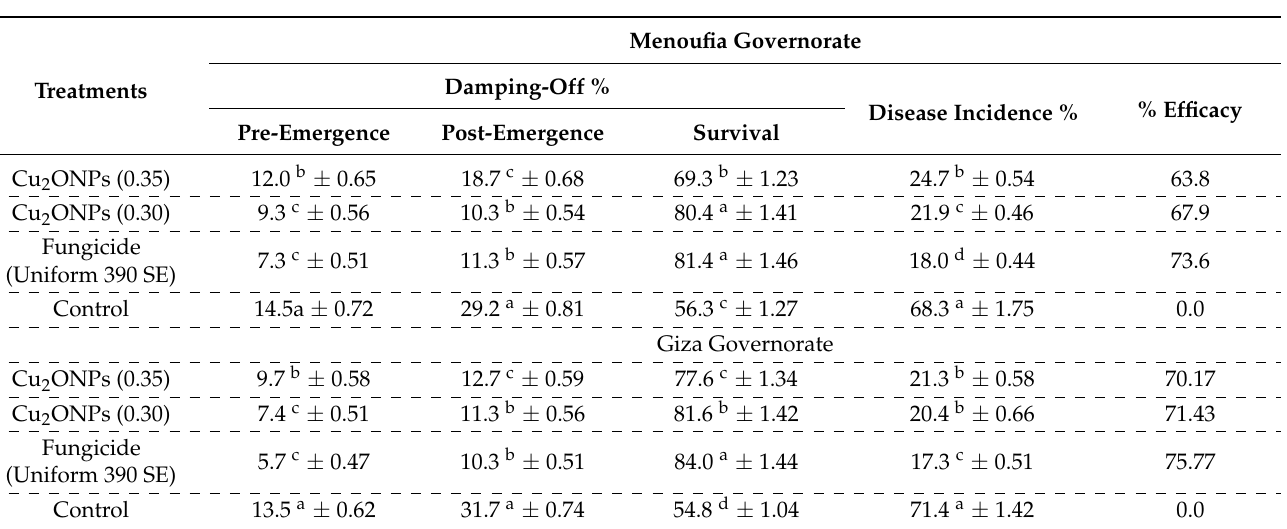
Table 5. Effect of Cu 2 ONPs compared to the fungicide on the percentages of damping-off and root rot disease incidence of F. solani in cucumber plants under field conditions in Menoufia and Giza Governorates.